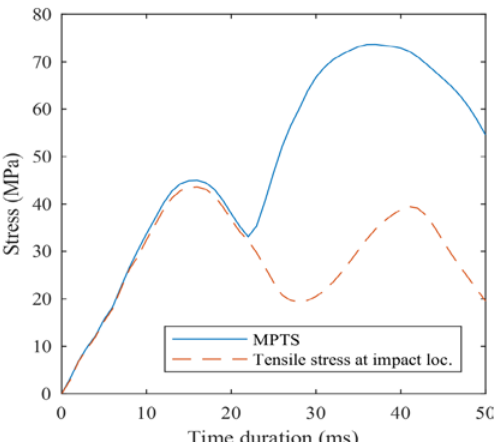
Fig. 10 Results of numerical simulations. Maximum principal tensile stress and tensile stress at the impact location (on opposite face of panel) in the case of SGP interlayer and assuming impact location